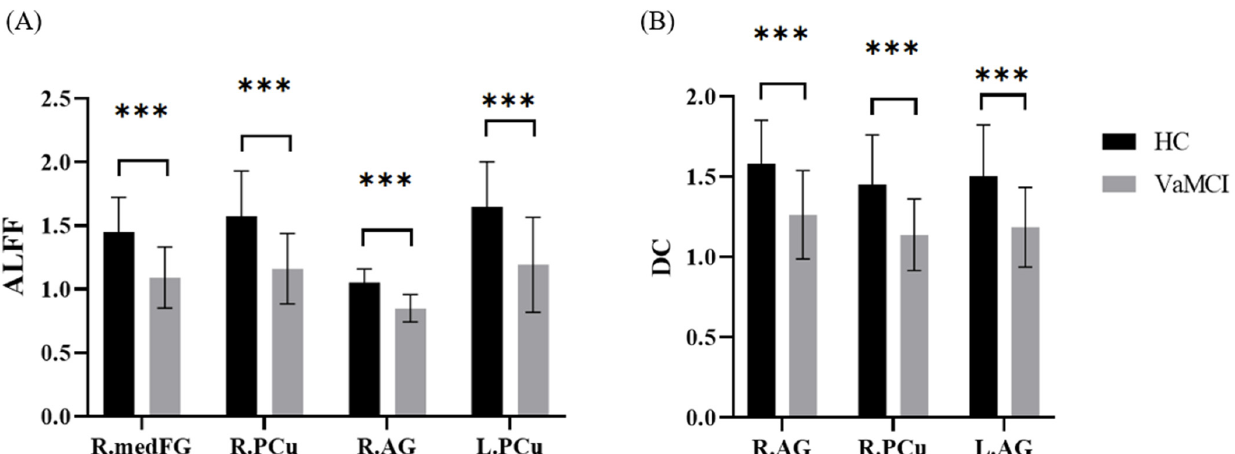
Figure 2. Comparison of significant brain regions between VaMCI group and HC group in extracted ALFF and DC values. ( A ) Comparison of ALFF values in the bilateral PCu, R.AG, and R.medFG between the VaMCI group and HC group. ( B ) Comparison of DC values in the R.PCu and bilateral AG between the VaMCI group and HC group. HC, healthy control; VaMCI, vascular mild cognitive impairment; PCu, precuneus; AG, angular gyrus; medFG, medial frontal gyrus; L., left; R., right. *** p < 0.001. Table 3. Decreased DC in VaMCI compared to HC.